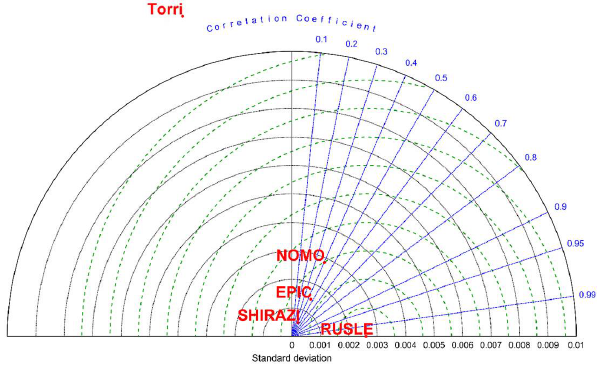
Figure 3. The Taylor analysis of different models.